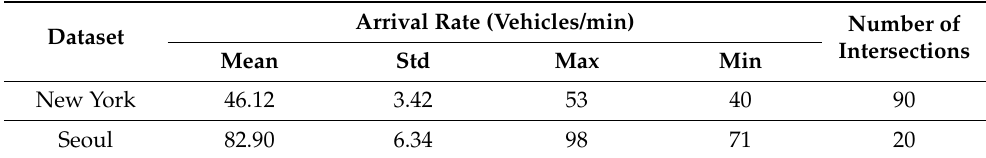
Figure 6. Road network for real-world data: ( a ) Part of Hell’s Kitchen, Manhattan, New York, USA and ( b ) Central area of Jung-gu, Seoul, South Korea. For both road networks, the coverage of the monitored area is marked with black lines, and red points represent corresponding intersections in the area. Table 2. Summary of two real-world